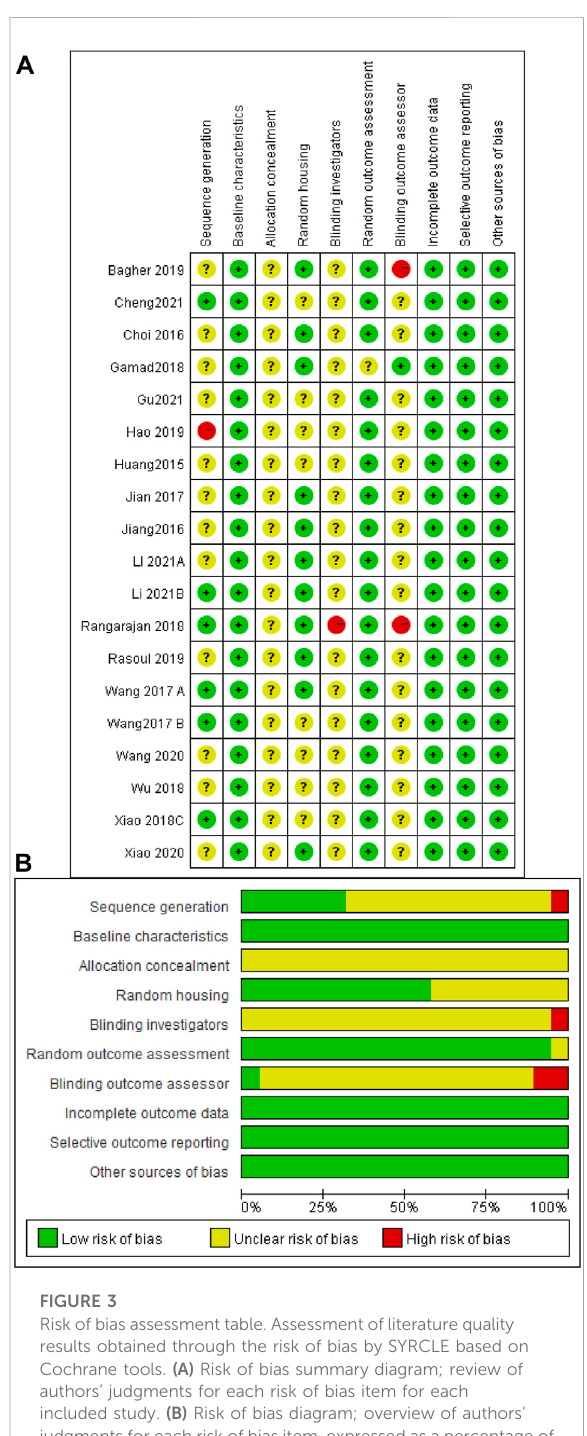
FIGURE 3 Risk of bias assessment table. Assessment of literature quality results obtained through the risk of bias by SYRCLE based on Cochrane tools. (A) Risk of bias summary diagram; review of authors ’ judgments for each risk of bias item for each included study. (B) Risk of bias diagram; overview of authors ’ judgments for each risk of bias item, expressed as a percentage of all included